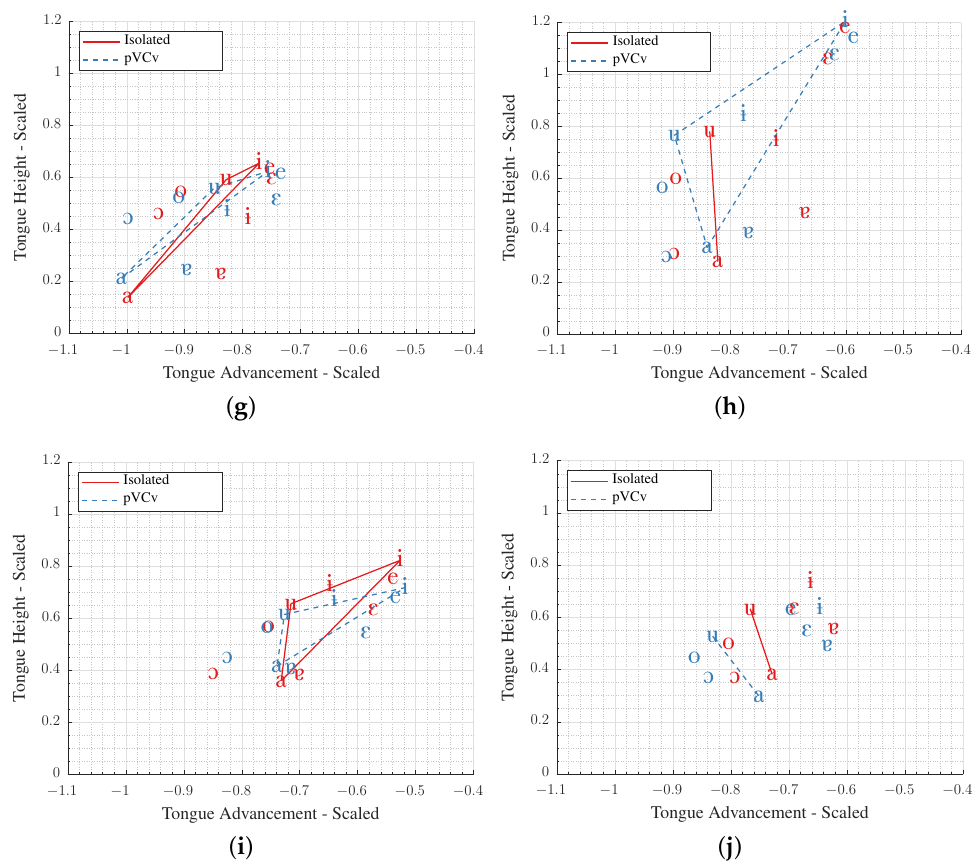
Figure 8. Articulatory vowel space of the EP cardinal vowels in isolated (red solid lines) and in pVCv context (blue dashed lines). The remaining vowels are also represented. Left side: young females (Y1 to Y5) ( a , c , e , g , i ); right side: old females (O1 and O5) ( b , d , f , h , j ).